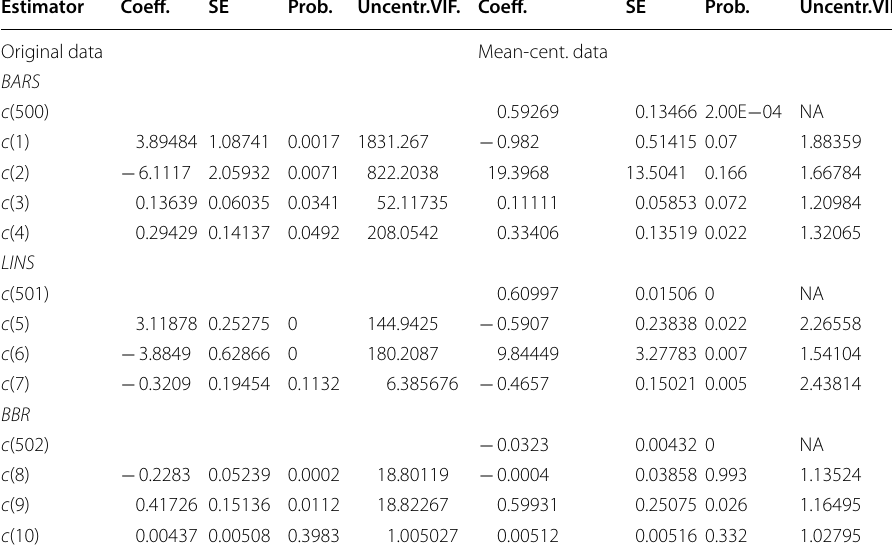
Table 1 Estimations by a mean-centering procedure compared with the original data Estimator Coeff. SE Prob. Uncentr.VIF. Coeff. SE Prob.